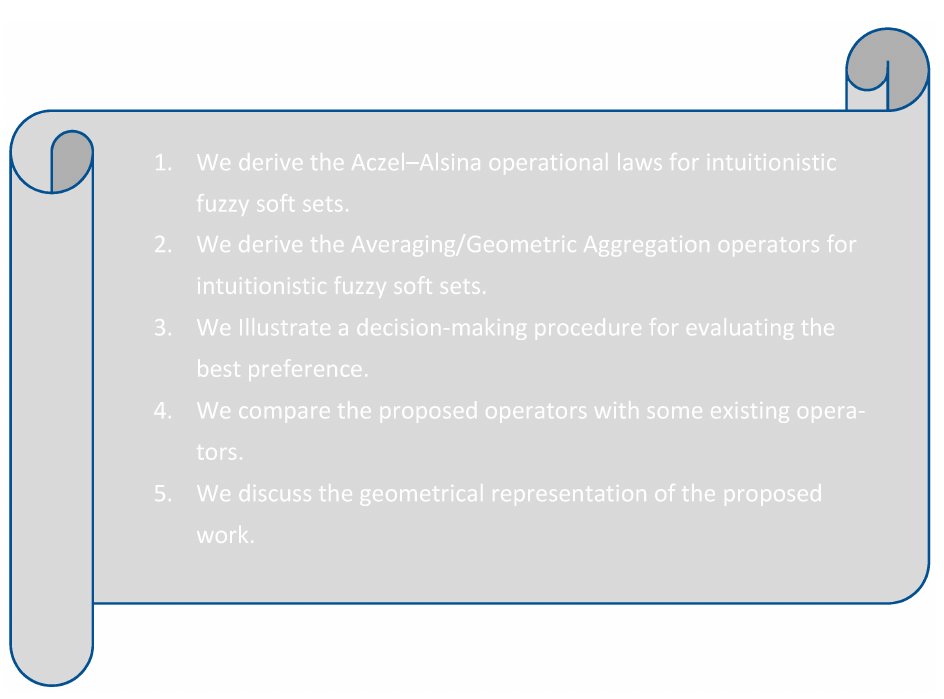
Figure 1. Geometrical representation of the proposed work.